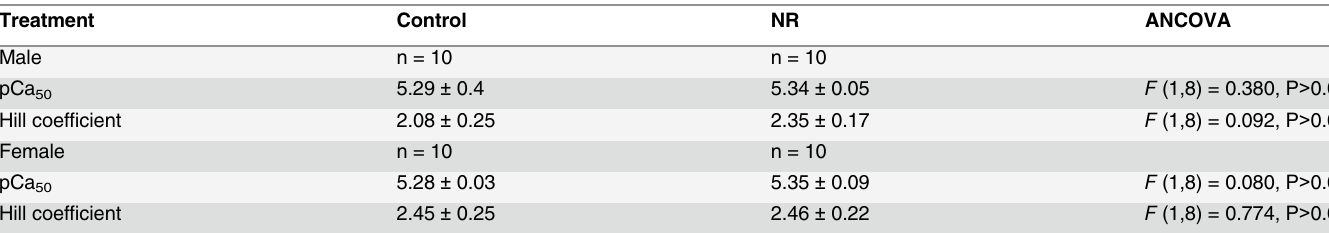
Table 3. Ca 2+ sensitivity of contractile apparatus in male and female offspring. All data expressed as mean ± SEM.